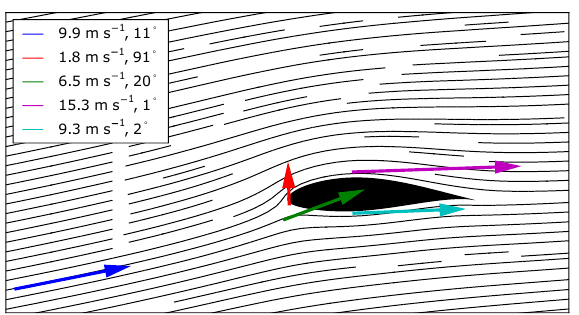
Figure 1. Near the airfoil, the flow is disturbed by upwash and stag- nation. This effect is not included in the current method.